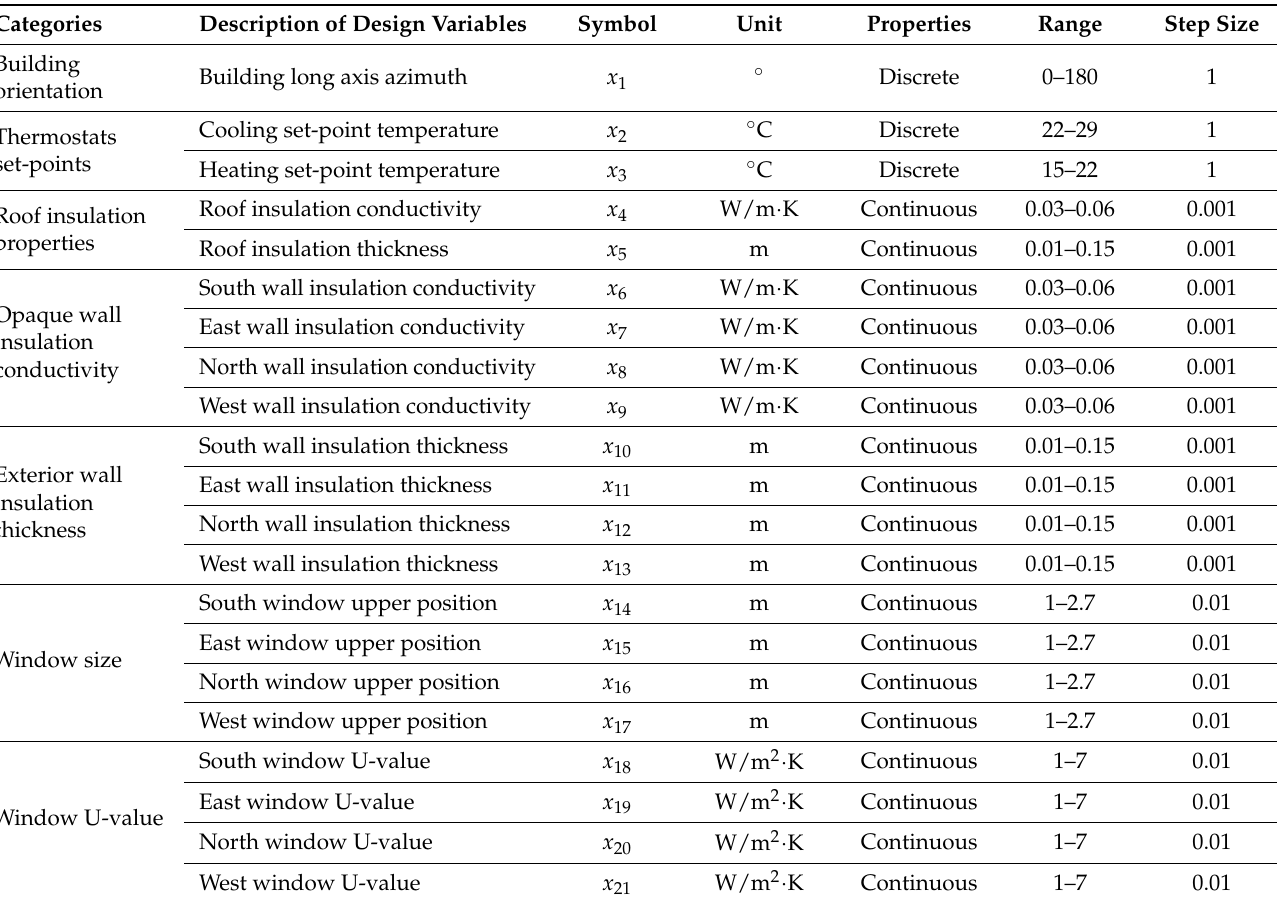
Table 2. Specifications of the optimization